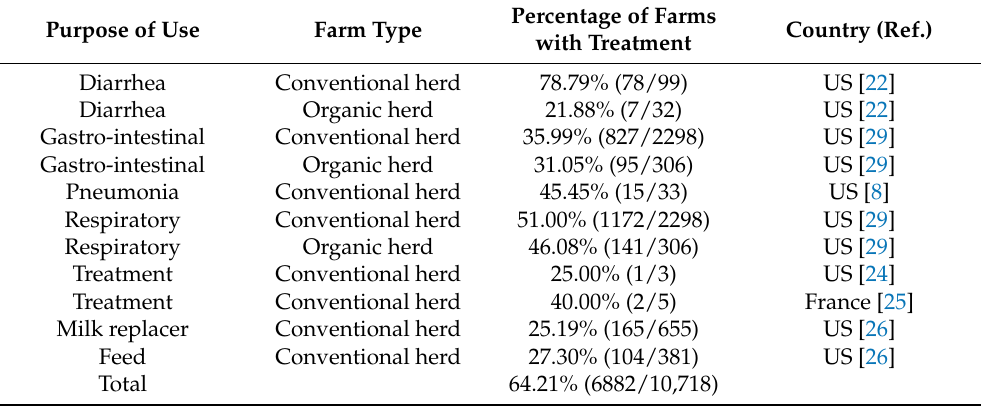
Table 1. Antimicrobial use for different purposes among different farm types. Number of farms with treatment divided by the total number of farms in